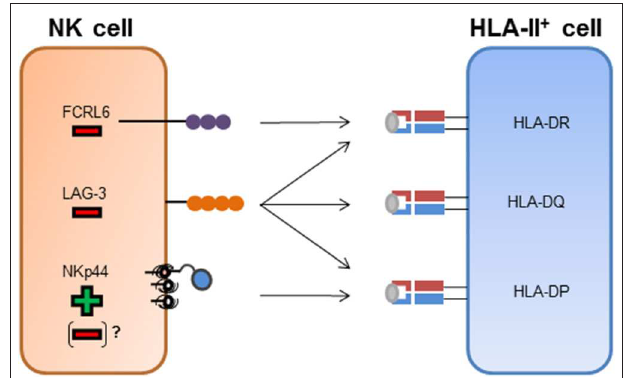
FIGURE 1 | NK cell receptor interactions with HLA class II molecules. FCRL6 + NK cells have been shown to interact with HLA-DR molecules. The binding of FCRL6 to HLA-DR molecules inhibits NK cell function. LAG-3 has been described to bind to HLA-II molecules and has been attributed an inhibitory function after engagement of HLA-II molecules. NKp44 has been described to bind to a subset of HLA-DP molecules and transmit activating signals after binding. Inhibitory splice isoforms of NKp44 expressed on tissue-resident NK cells or NKp44 expression on other innate immune cells might transmit inhibitory signaling after engagement of HLA-DP